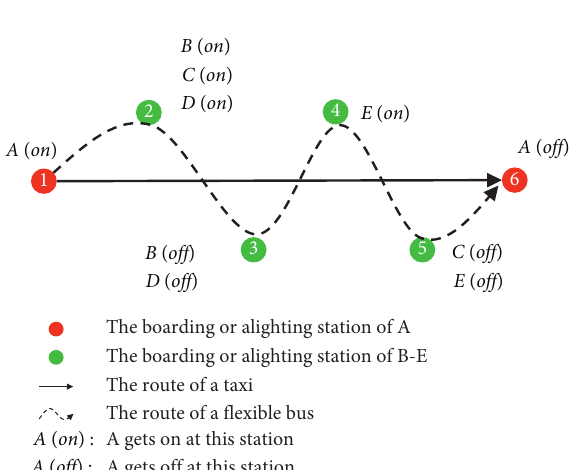
Figure 5: Boarding and alighting stations of